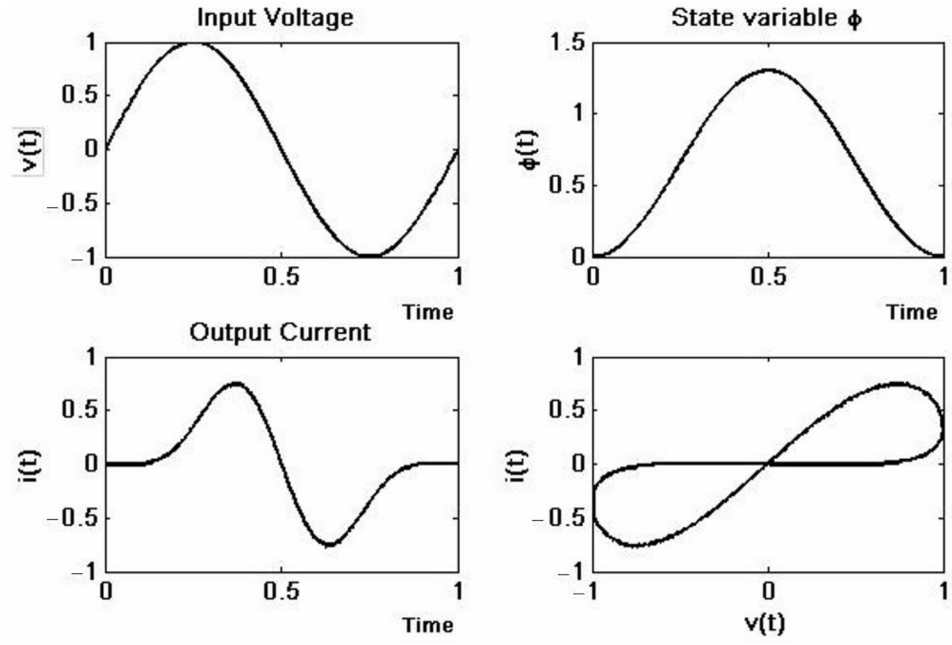
Figure 6. FPAA memristor emulator